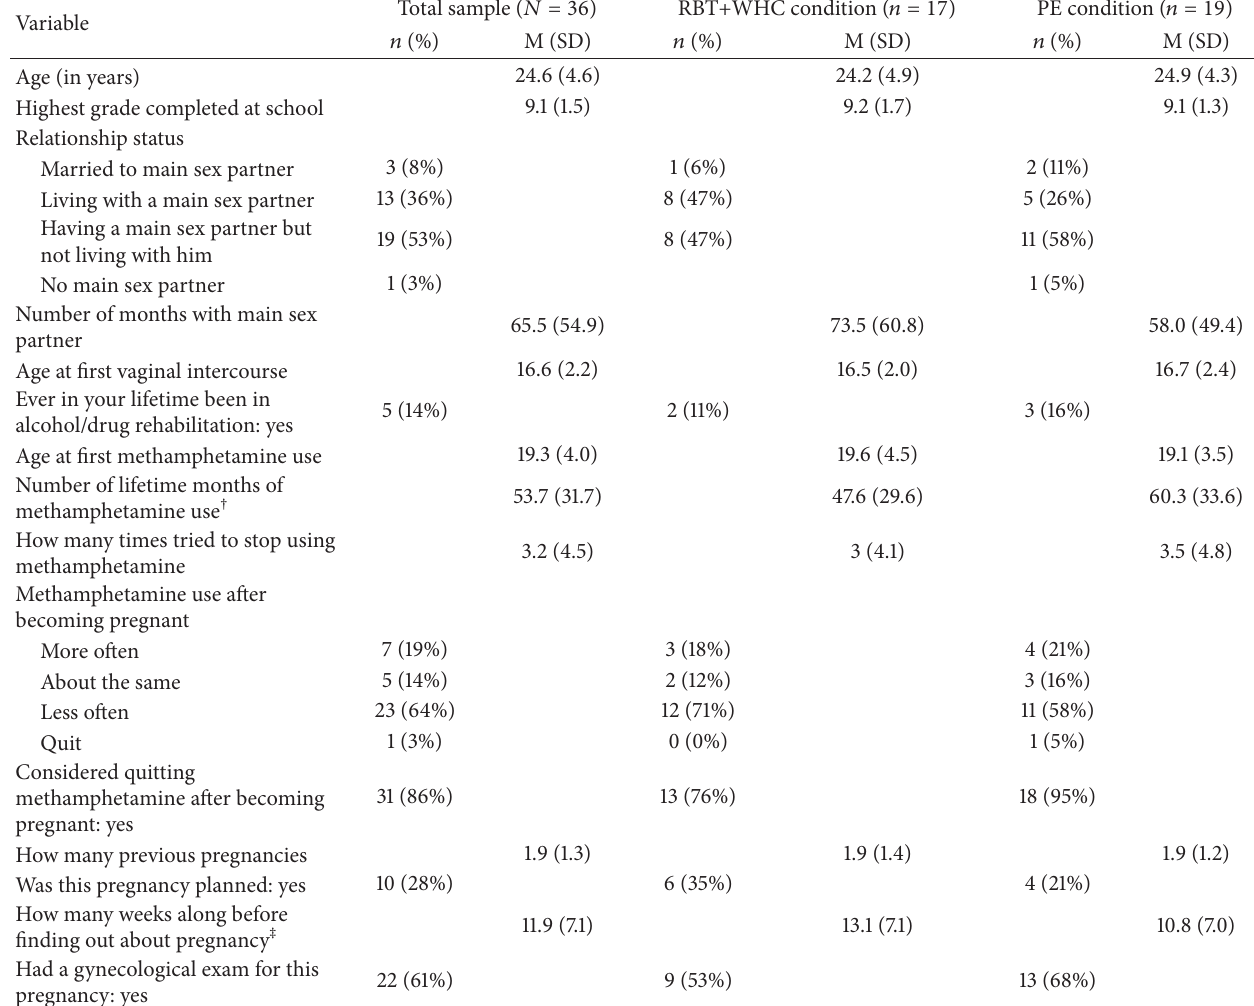
Table 1: Demographic and selected background characteristics ( 𝑁 = 36